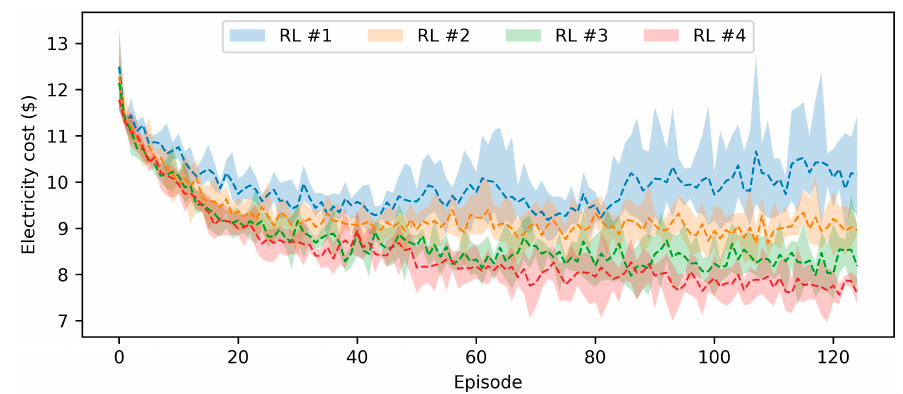
Figure 6. Training performance of the RL agents.